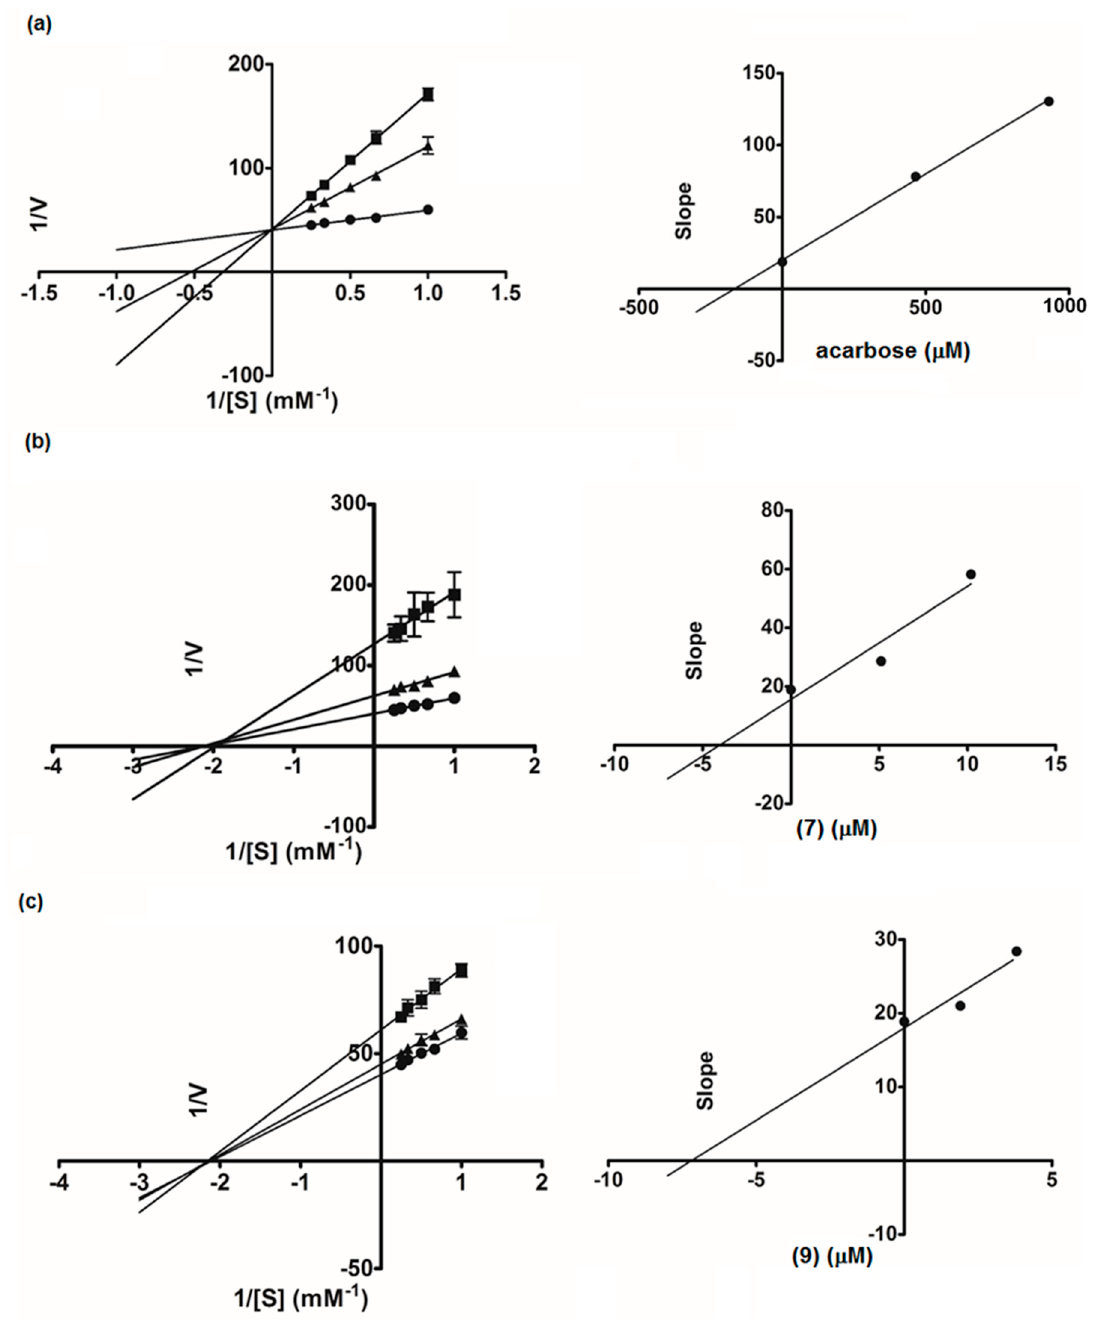
Figure 4. Lineweaver-Burk plots of acarbose ( a ): ● control, ■ acarbose 600 µg/mL, ▲ acarbose 300 µg/mL; hydroxypandurantin A ( 7 ) ( b ): ● control, ■ ( 7 ) 4 µg/mL, ▲ ( 7 ) 2 µg/mL; Compound 9 ( c ): ● control, ■ ( 9 ) 2 µg/mL, ▲ ( 9 ) 1 µg/mL. The secondary plot of each compound is on the right.